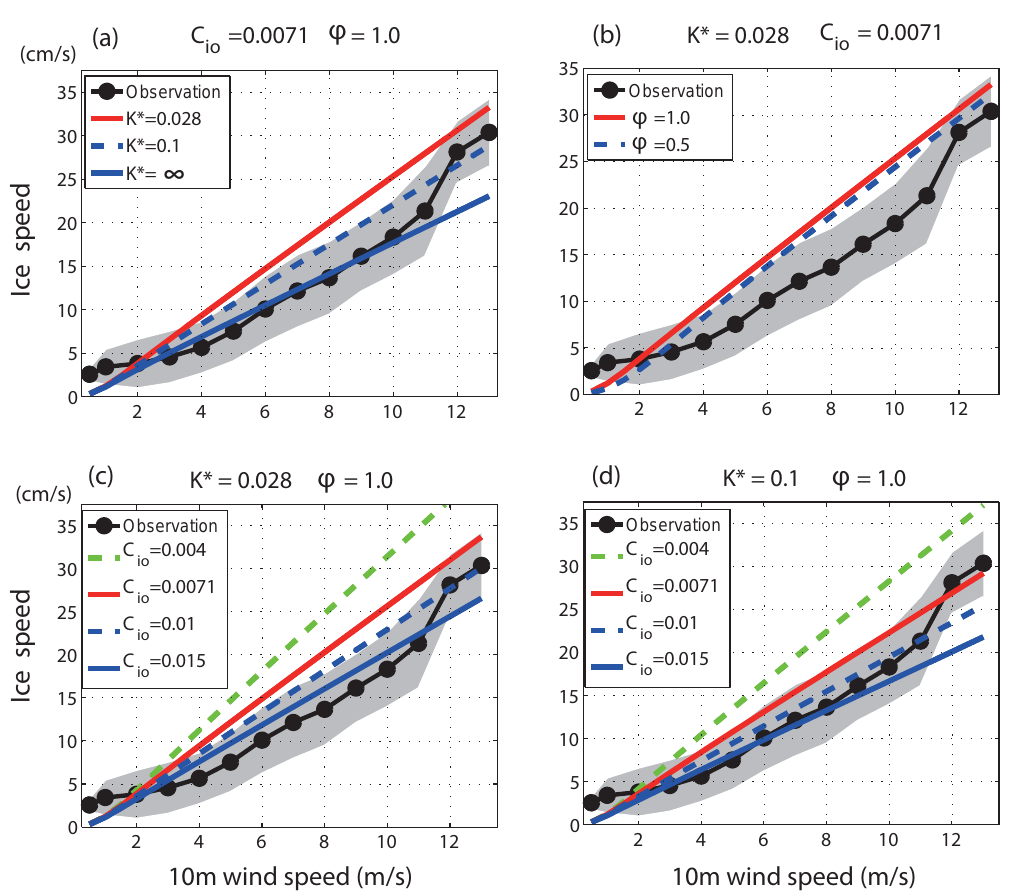
Figure 3. Sensitivity of ice speed (cms − 1 ) to 10m wind speed (ms − 1 ). The black line shows the mean value calculated from ITP-V 35 observations binned by 10m wind speed, and the gray shadings indicate the range of 1 standard deviation from the mean. The red, dotted blue, and solid blue lines correspond to our analytical model, described in Sect. 2, with (a) vertical diffusivities K ∗ o = 0.028, 0.1, and ∞ (no IOBL), respectively. The sensitivity of the ice speed to the ice concentration ( ϕ ) is shown in (b) ; the red and blue lines indicate 100% ice cover ( ϕ = 1) and 50% ice cover ( ϕ = 0.5), respectively. The bottom panel shows the sensitivity of ice speed to ice–ocean drag coefficient ( C io ), with vertical diffusivities (c) K ∗ o = 0.028 and (d) K ∗ o = 0.1, respectively. The bulk sea ice thickness is taken to be